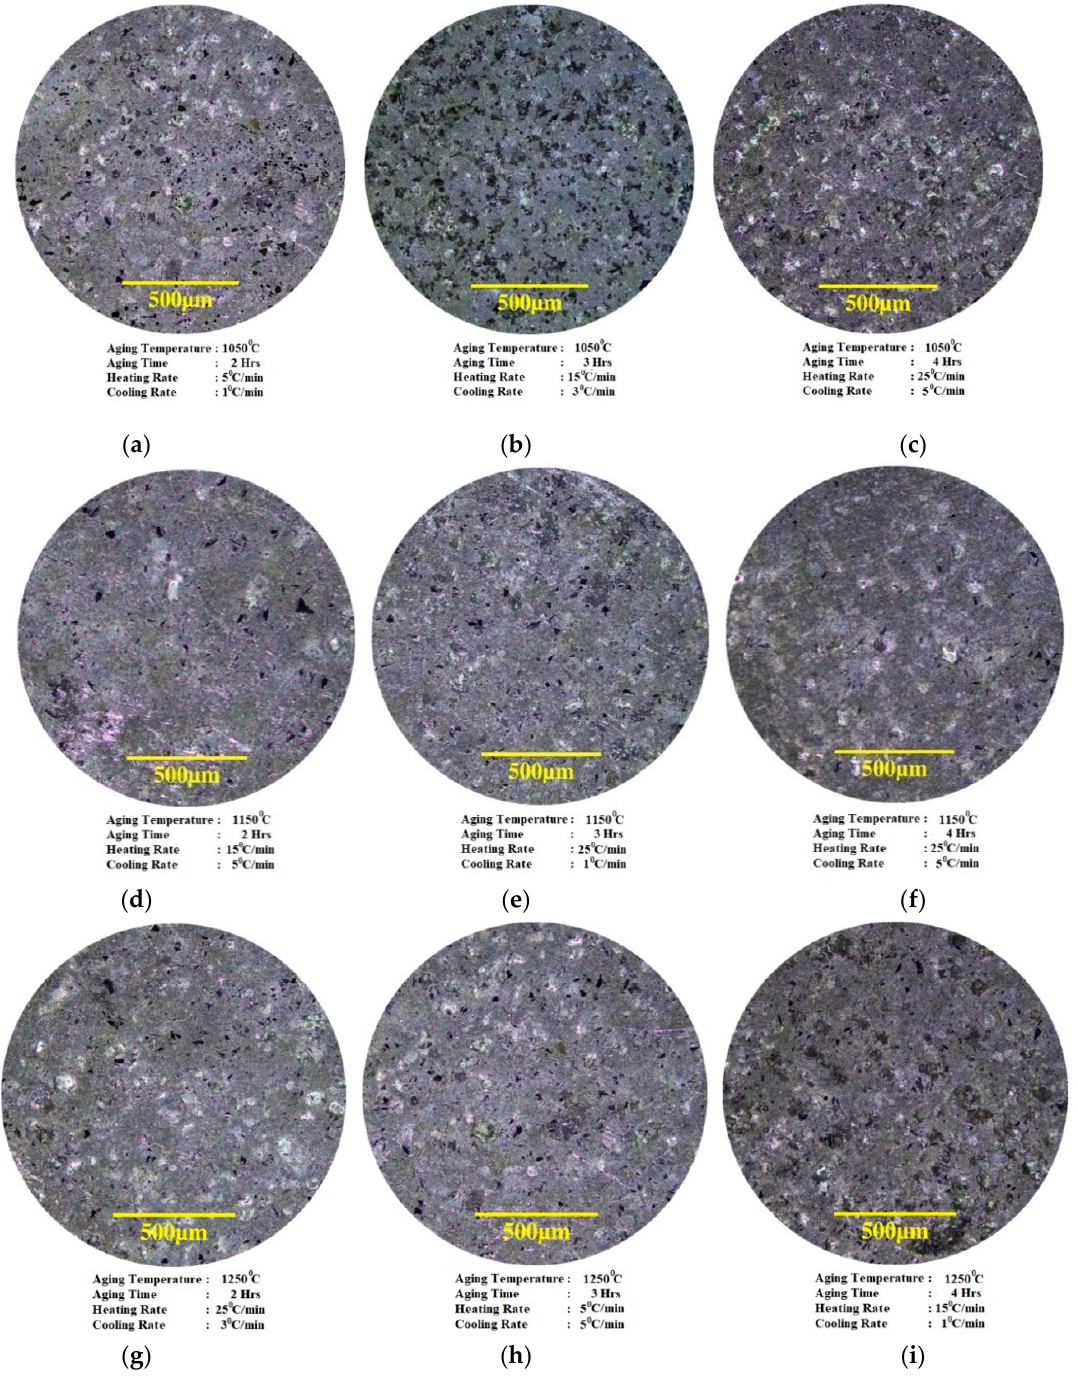
Figure 18. Metallographic images of Ti-6Al-4V-SiC(15 Wt.%) processed under various conditions. Scanning electron microscopy with elemental mapping using X-rays was used to analyze the microstructure of a Ti-6Al-4V-SiC (15 Wt.%) specimen processed under aging temperature (1150 ◦ C), aging time (four hours), heating rate (25 ◦ C/min), and cooling rate (5 ◦ C/min). The microstructure (Figure 19) grains of Ti 3 SiC 2 can be identified along with void spaces and un-transformed SiC particulates embedded in the Ti-6Al-4V matrix alloy. From the elemental mapping (Figure 20) of the Ti-6Al-4V-SiC(15 Wt.%) specimen, the distribution of elements (titanium, silicon, and, carbon)